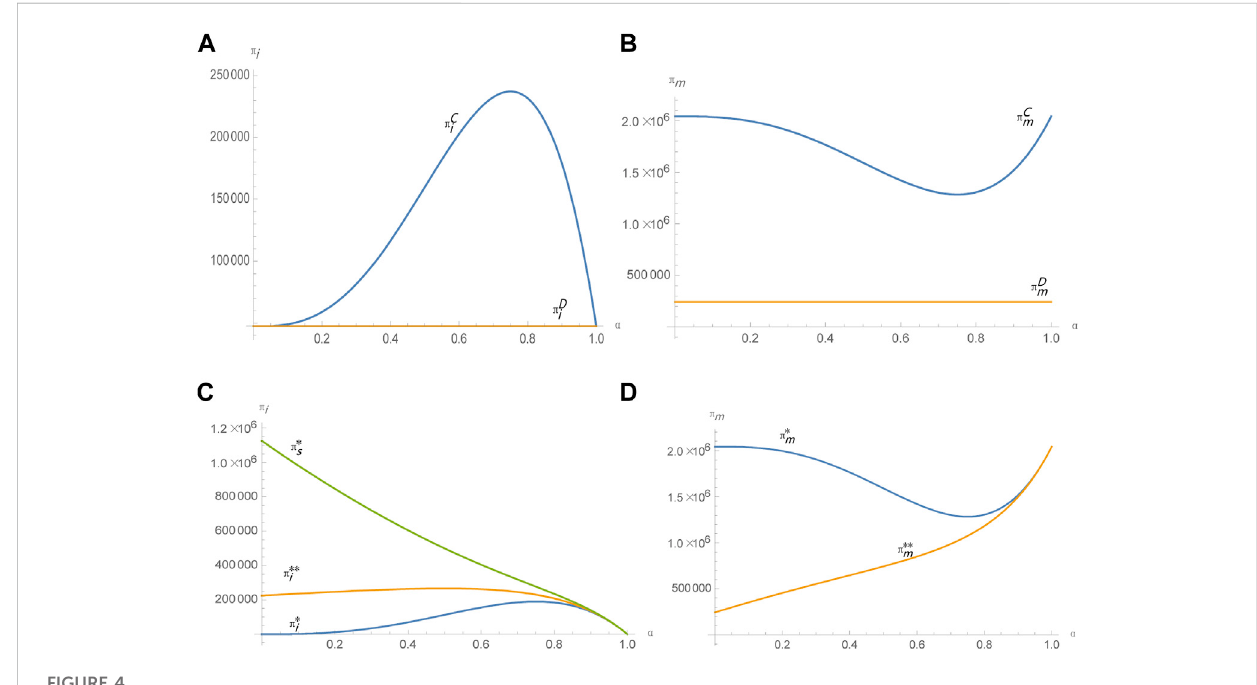
FIGURE 4 Impact of alliance cooperation on corporate pro fi